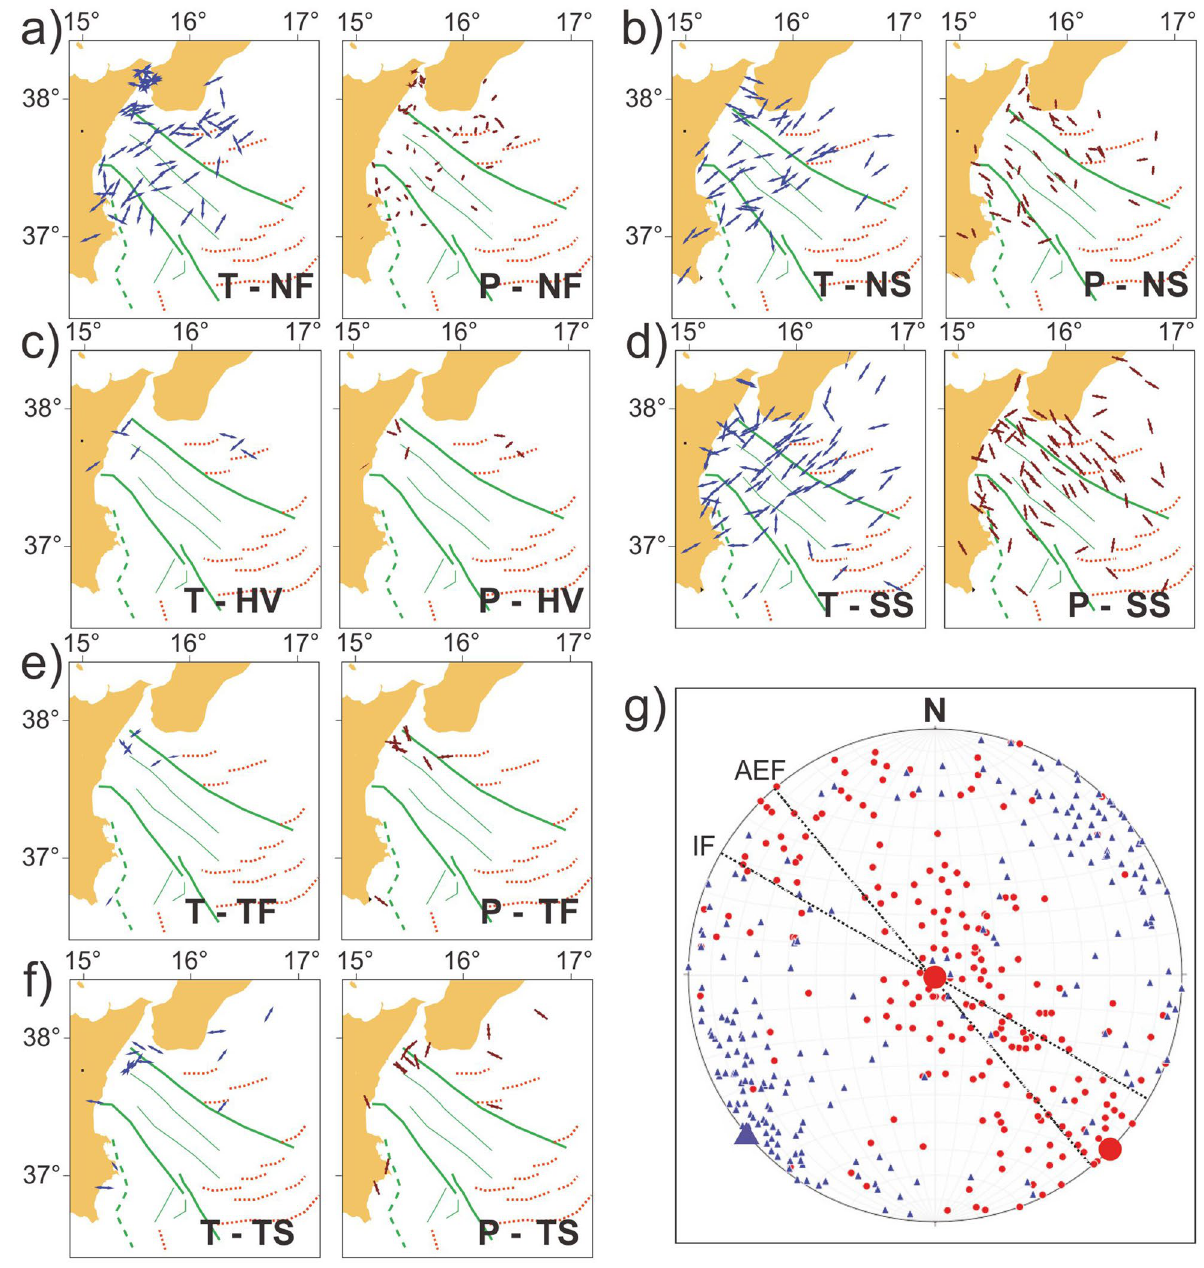
Figure 5. Maps of the orientation of P- and T-axes subdivided in normal fault ( a ), normal-strike ( b ), horizontal-vertical ( c ), strike-slip ( d ), thrust fault ( e ), and thrust-strike ( f ). Synoptic polar diagram of P- and T-axes ( g ). Maps are compiled using GMT package (version 6.0.0; https ://www.gener ic-mappi ng-tools .org/) and image was edited using Adobe Illustrator (CS6; https ://www.adobe